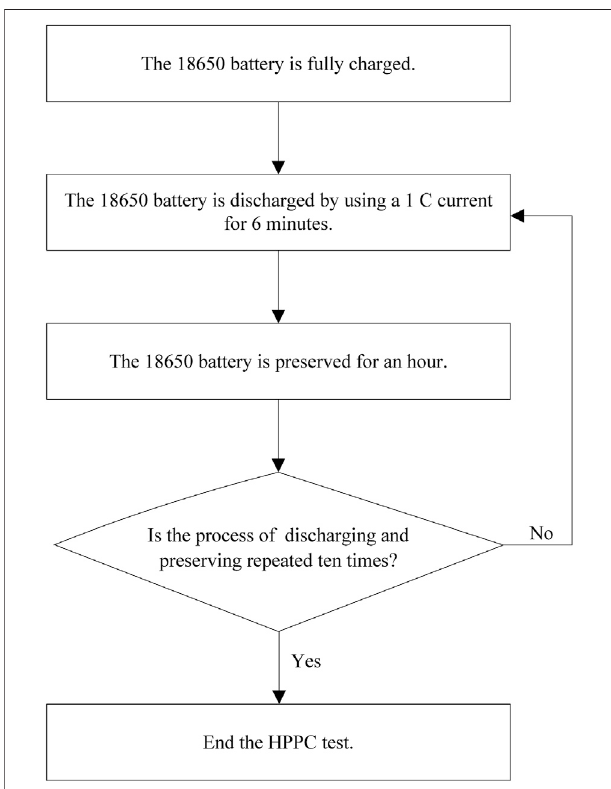
FIGURE 3 | HPPC test procedure.